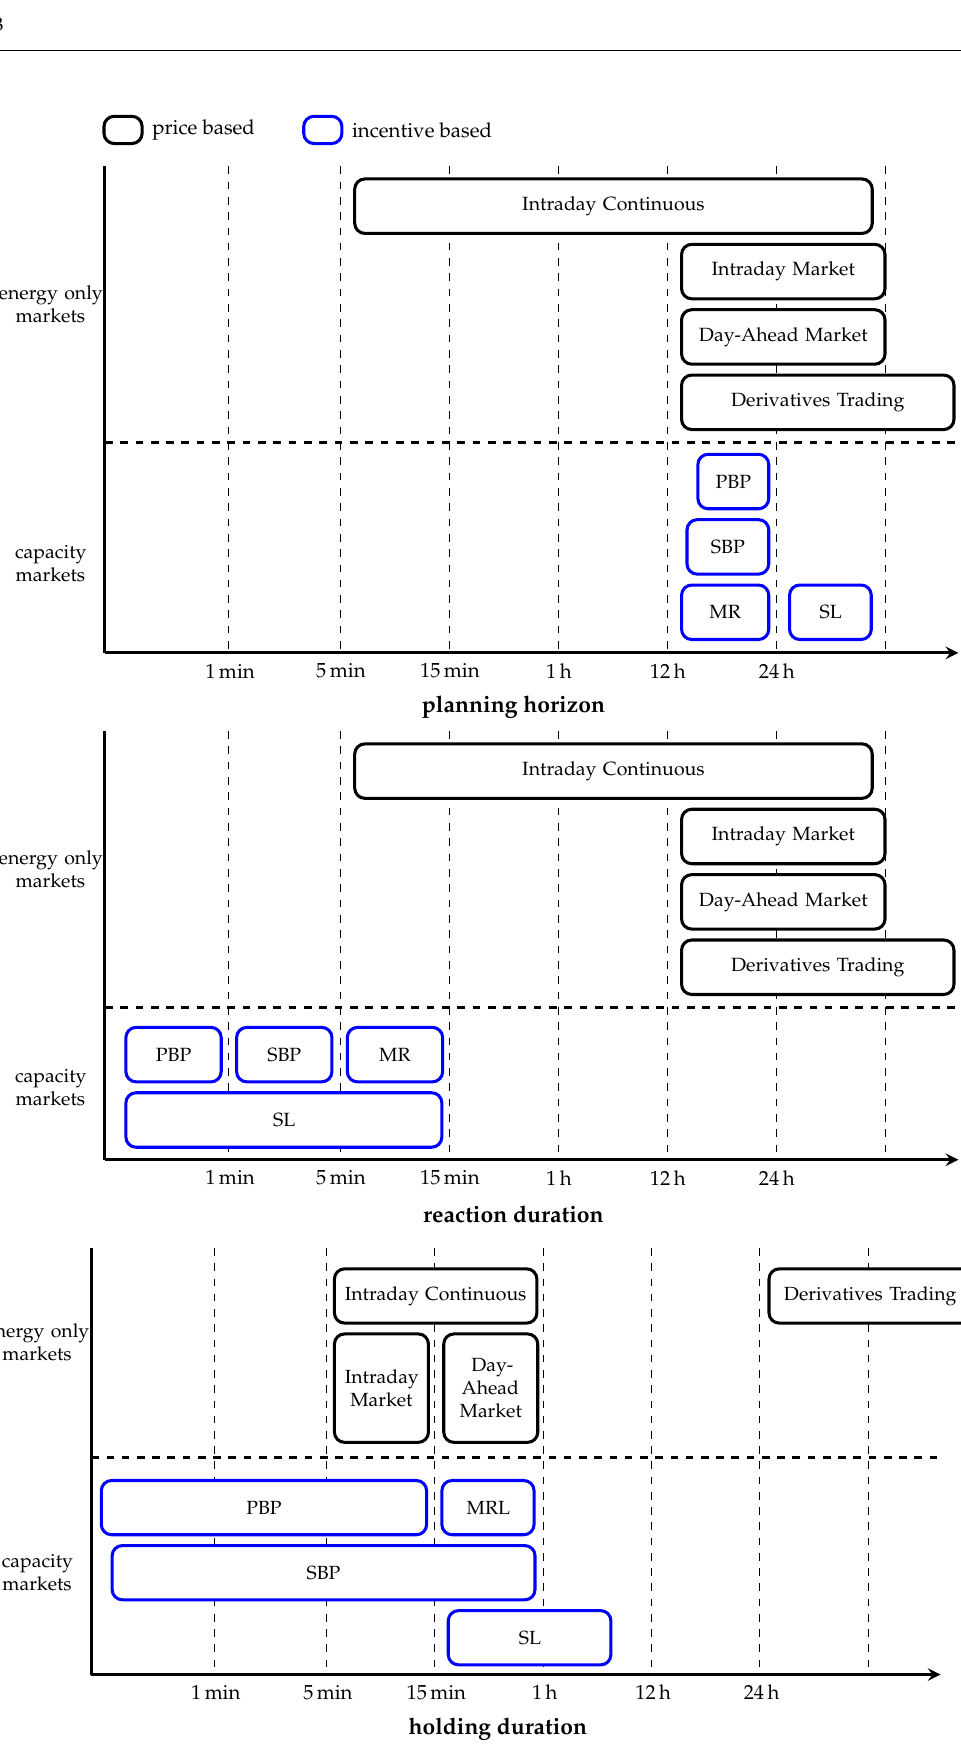
Figure 5. Monetisation options for IDSI depending on the planning horizon, reaction, and holding duration (own illustration based on